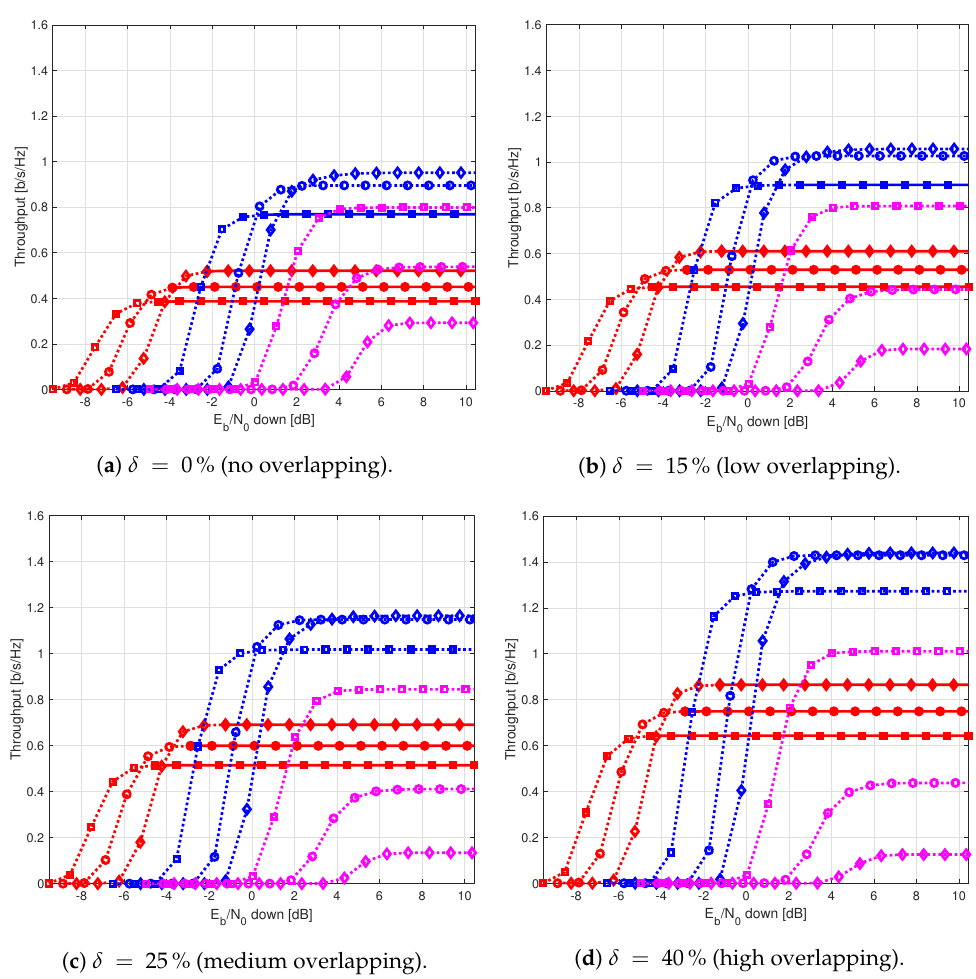
Figure 12. End-to-end throughput versus E b / N 0 in the access link for a NB-IoT frame in a regen- erative satellite (Decode-and-Forward with NB-IoT) (SNR fl = 15dB). NB-IoT code rates: 0.2222 (red square), 0.259 (red circle), 0.3 (red diamond), 0.444 (blue square), 0.5319 (blue circle), 0.6 (blue diamond), 0.6386 (magenta square), 0.7678 (magenta circle) and 0.8628 (magenta diamond). Solid (dashed-) lines with (un)filled markers: BLER ≤ 10 − 2 requirement (not) fulfilled. Wind speed: v = 21 m/s. Diameter of telescope aperture: W 0 =